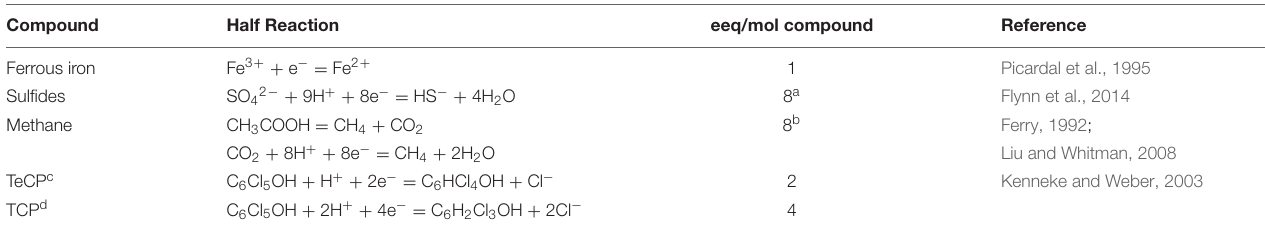
TABLE 1 | Relevant half reactions of the electron acceptors during 120 days